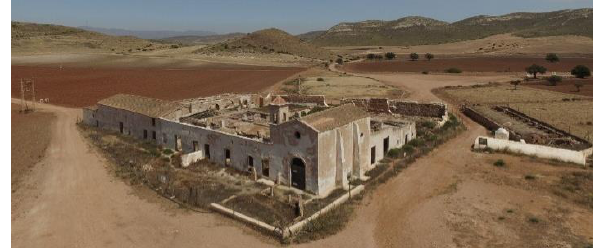
Fig. 1. Actual image of the main façade of Cortijo del Fraile